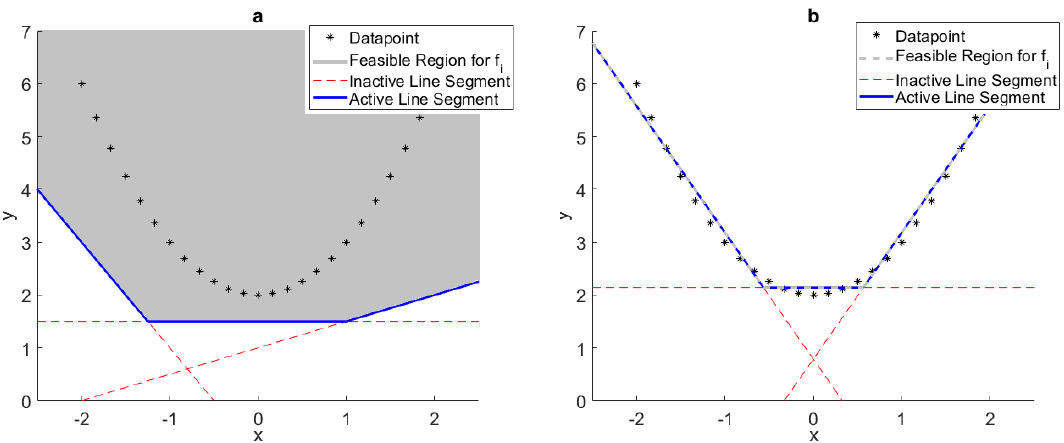
Figure 5. ( a ) Example of potential approximation produced when only the f i ≥ c k x i + d k constraint is used in the PLFG MILP; ( b ) Example of potential approximation produced when all of the constraints are used in the PLFG MILP (PLFG: Piecewise-Linear Function Generation; MILP: mixed-integer linear